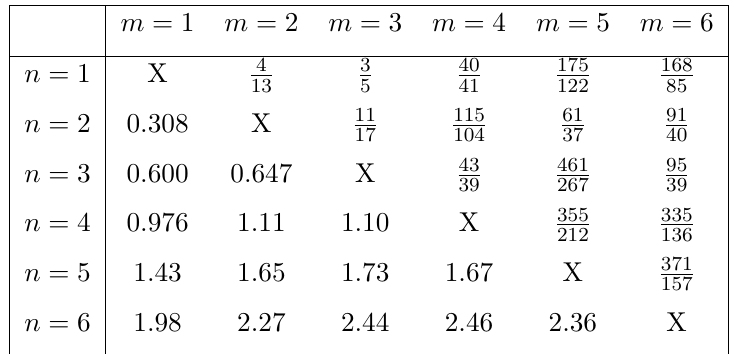
Table 3 . Values of h/c at which the sectional curvatures K ( u, v ) turn from negative to positive, for small values of m, n . This is calculated from equation (5.8) for m > n , and as in table 2 we display both exact and approximate